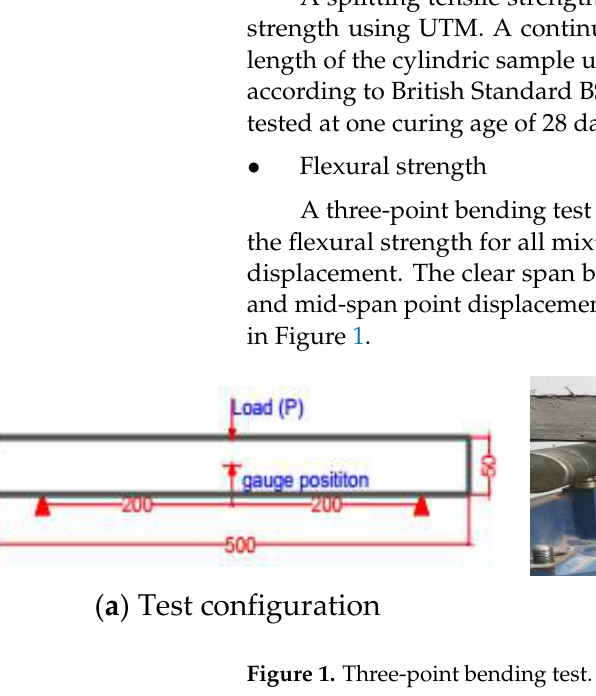
Figure 1. Three-point bending test.